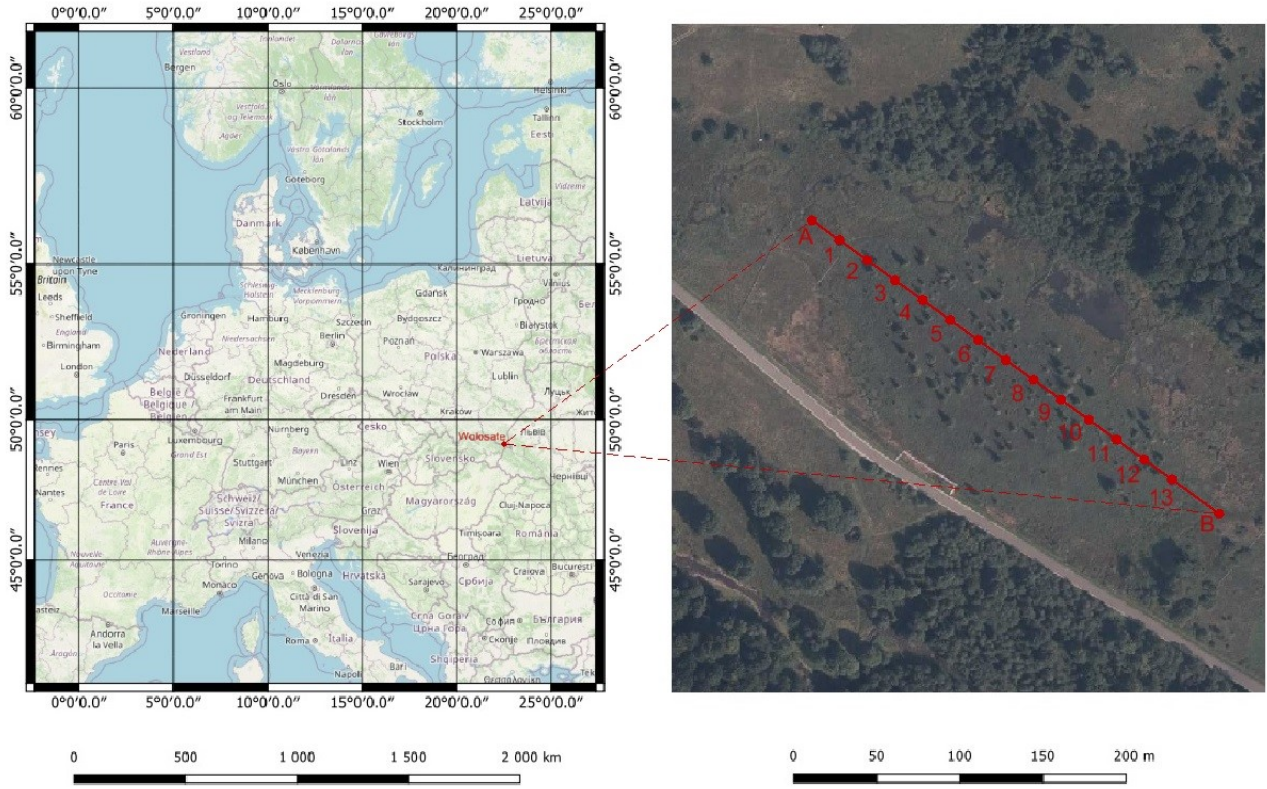
Figure 1. Location of the “Wołosate” raised bog, A-B—transect of the „Wołosate” bog in the Western Bieszczady Mountain. (https://www.google.com/maps/@52.5319205,19.269814,6z?hl=en, accessed on 3 November